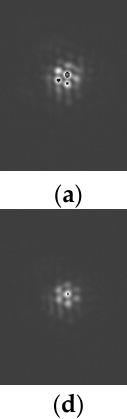
Figure 10. Images obtained from the focal plane detector feedback during the tracking of trajectory-2.